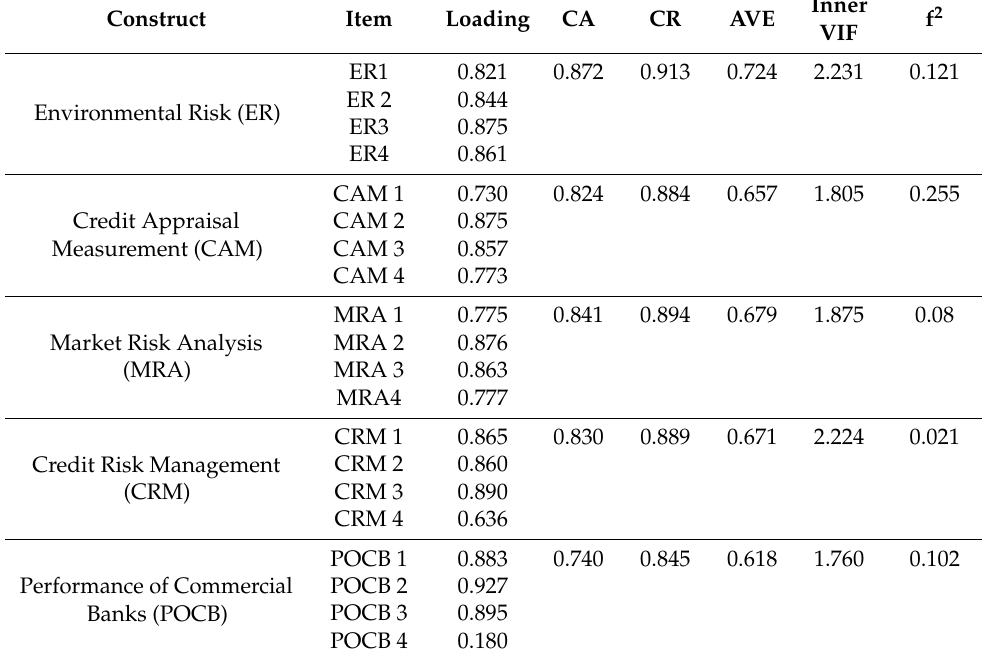
Table 3. Description of the measurement